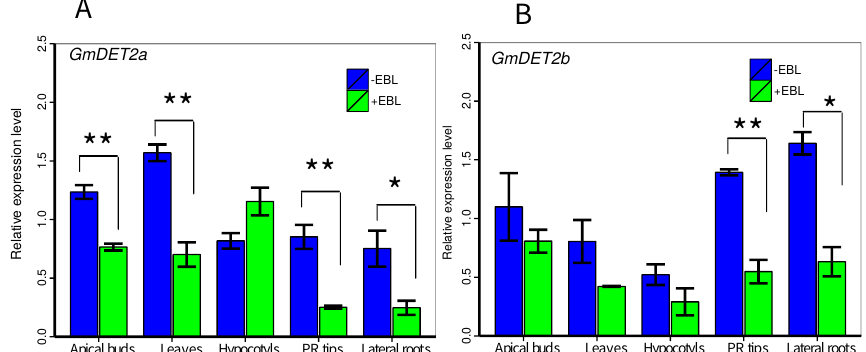
Figure 6. Responses of GmDET2a and GmDET2b to exogenous epibrassinosteroid (EBL) in soybean seedlings. RNA was extracted from five-day-old soybean YC03-3 treated with 10 µ M EBL for 6 h or not. Quantitative real-time PCR was exploited to detect the transcripts of GmDET2a ( A ) and GmDET2b ( B ) in apical buds, leaves, hypocotyls, primary root (PR) tips and lateral roots. Results are the means ± SD from 4 replicates. Student’s t -test was used to compare the differences between EBL treatment and control, respectively (*, 0.01 < p < 0.05; **, 0.001 < p <